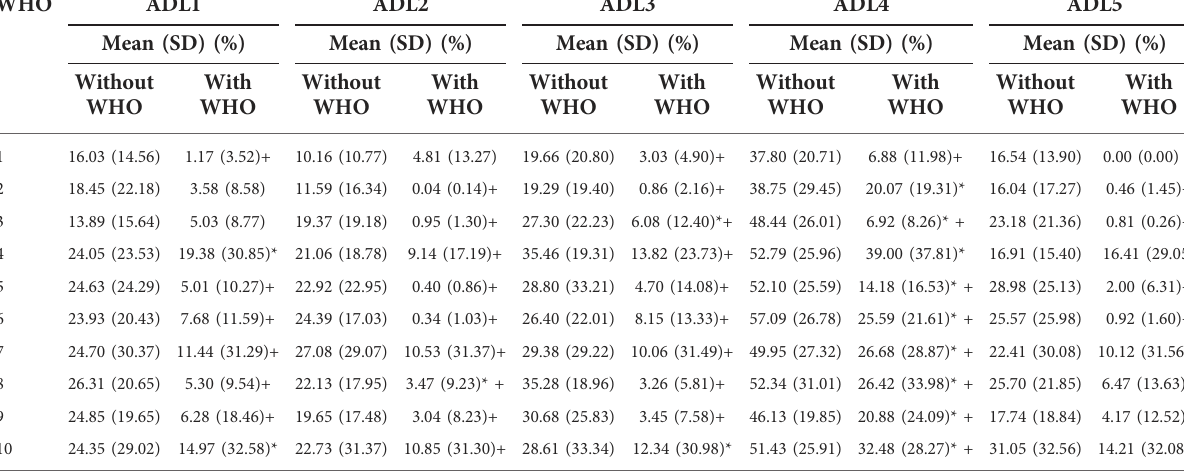
* and ** denote p <0.05 and p <0.001, respectively, when the percentage of timewas statistically greater than 0 with WHOs. Wilcoxon- matchedrank testswere used to test if the differences between with and without WHOs were statistically different, with + and ++ denoting statistical signi fi cance for p <0.05 and p <0.001, respectively. Highlighted in grey are those WHOs that were statistically greater than 0.